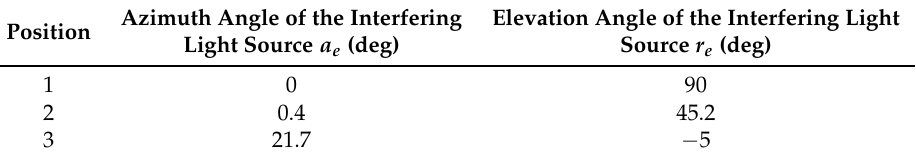
Table 1. Configurations of positions for the interfering light source.